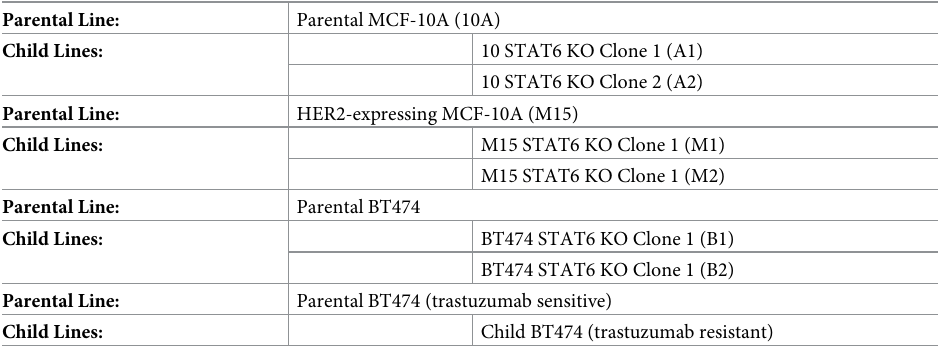
Table 1. Summary of cellular clones used in this